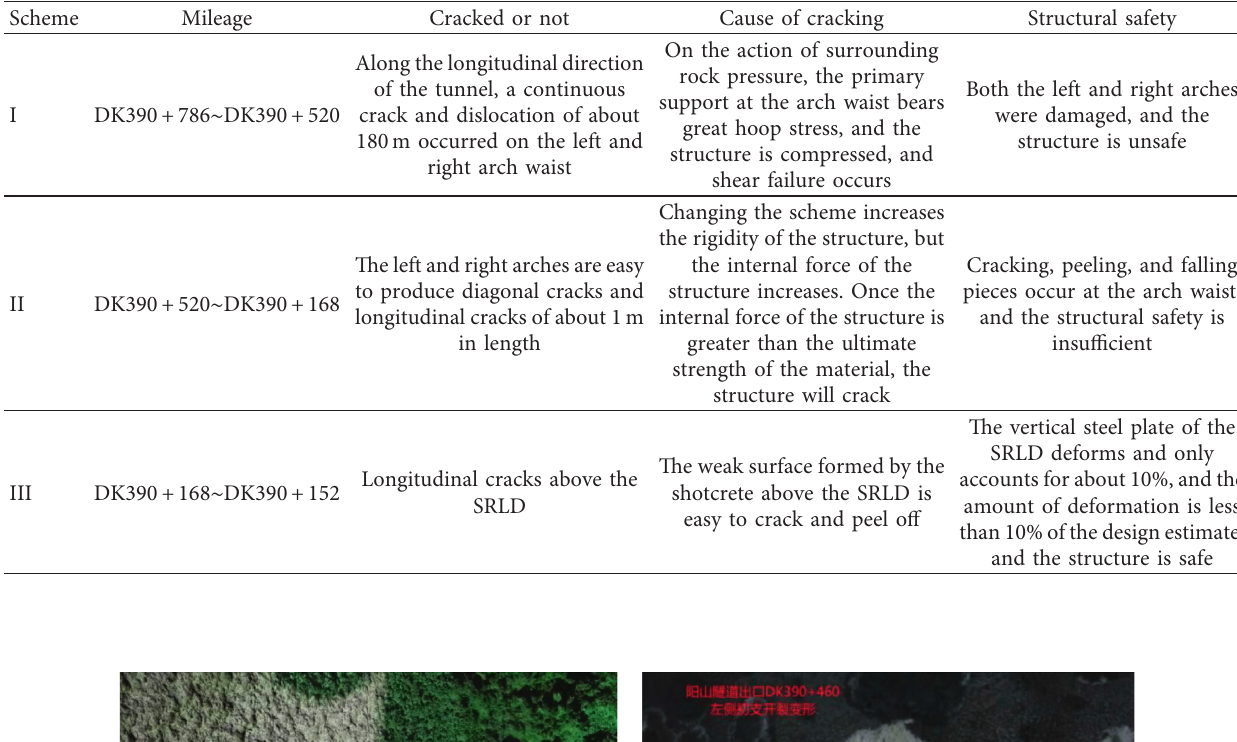
Table 5: Safety comparison